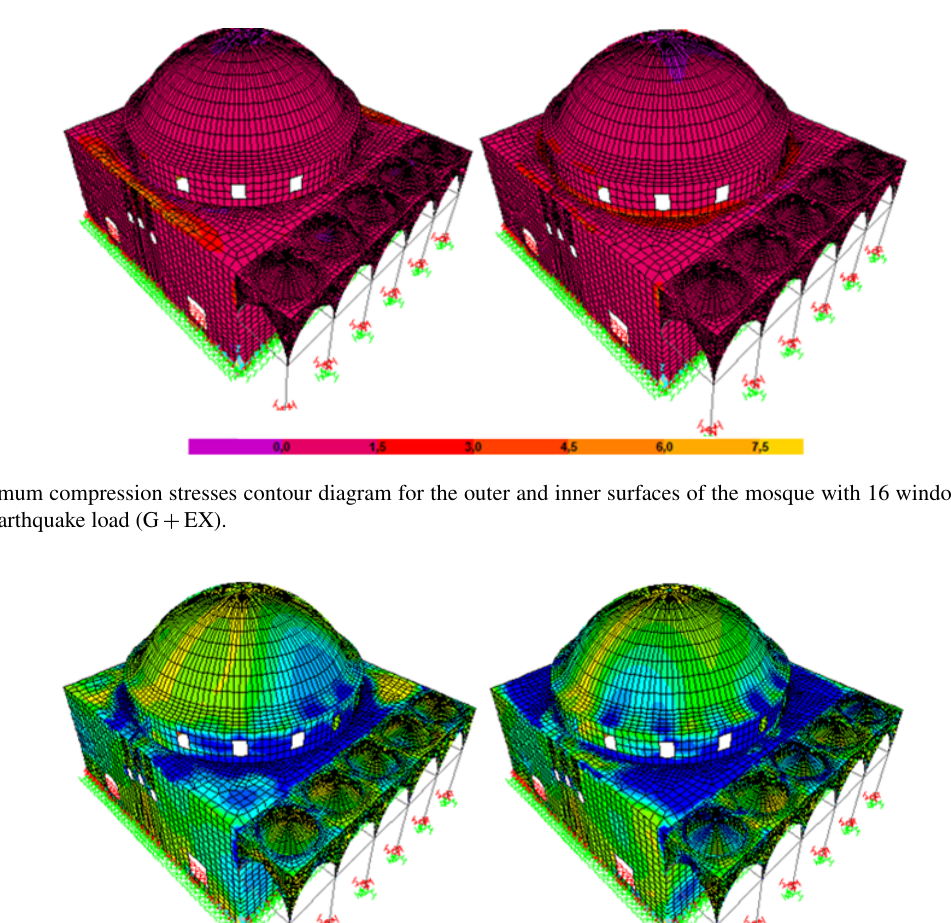
Figure 6. Maximum tensile stresses contour diagram for the outer and inner surfaces of the mosque with 16 window openings under dead load and earthquake load (G + EX).